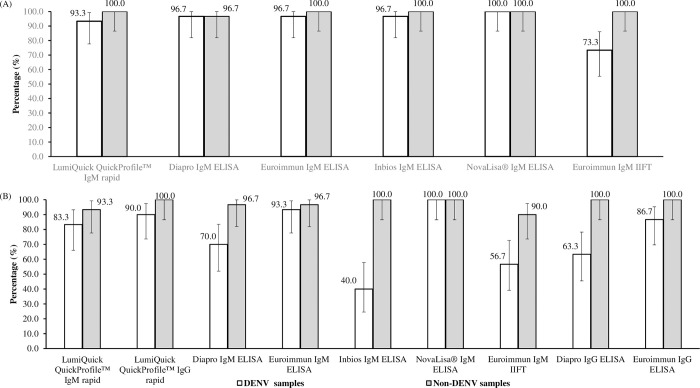
(A) Specificity of ZIKV IgM rapid ICT, ELISAs and IIFT using acute samples from DENV-confirmed (n = 30), and non-ZIKV and non-DENV (n = 30) patients. (B) Specificity of ZIKV IgM/IgG rapid ICT, IgM ELISAs/IIFT and IgG ELISAs using 7–34 days’ convalescent samples from DENV-confirmed (n = 30), and non-DENV patients (n = 30) (Set B). Confidence intervals (black bars) were constructed using Wald’s method. LumiQuick QuickProfile™ ZIKV IgM & IgG rapid ICTs refer to a combo test kit.